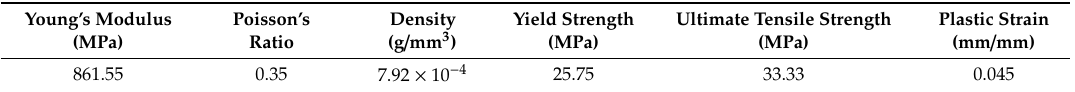
Table 1. Bulk material properties of ABS material.